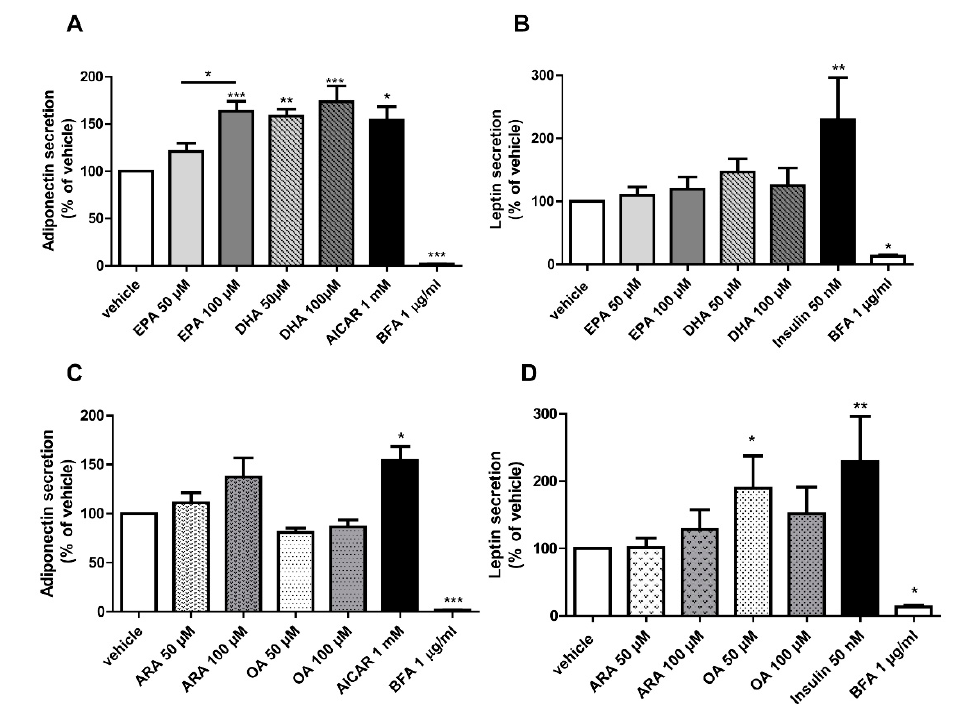
Figure 4. EPA and DHA differentially upregulate adiponectin secretion in human adipocytes. Effect of EPA and DHA incubation (50 and 100 μ M) for 24 h on adiponectin ( A ) or leptin secretion ( B ) in the adipocytes. Effect of ARA and oleic acid (OA) (50 and 100 μ M) for 24 h on adiponectin ( C ) or leptin secretion ( D ). Adiponectin and leptin concentration in the supernatants was determined by ELISA. AICAR (1 mM) was used as a positive control for adiponectin secretion and insulin (50 nM) was used as a positive control for leptin secretion, while brefeldin A (1 μ g/mL) was used as a negative control. Results were expressed as % of adiponectin/leptin levels triggered by the vehicle. Data are shown as mean ± SEM of 3–5 independent experiments. * p < 0.05, ** p < 0.01, *** p < 0.001 s vs.